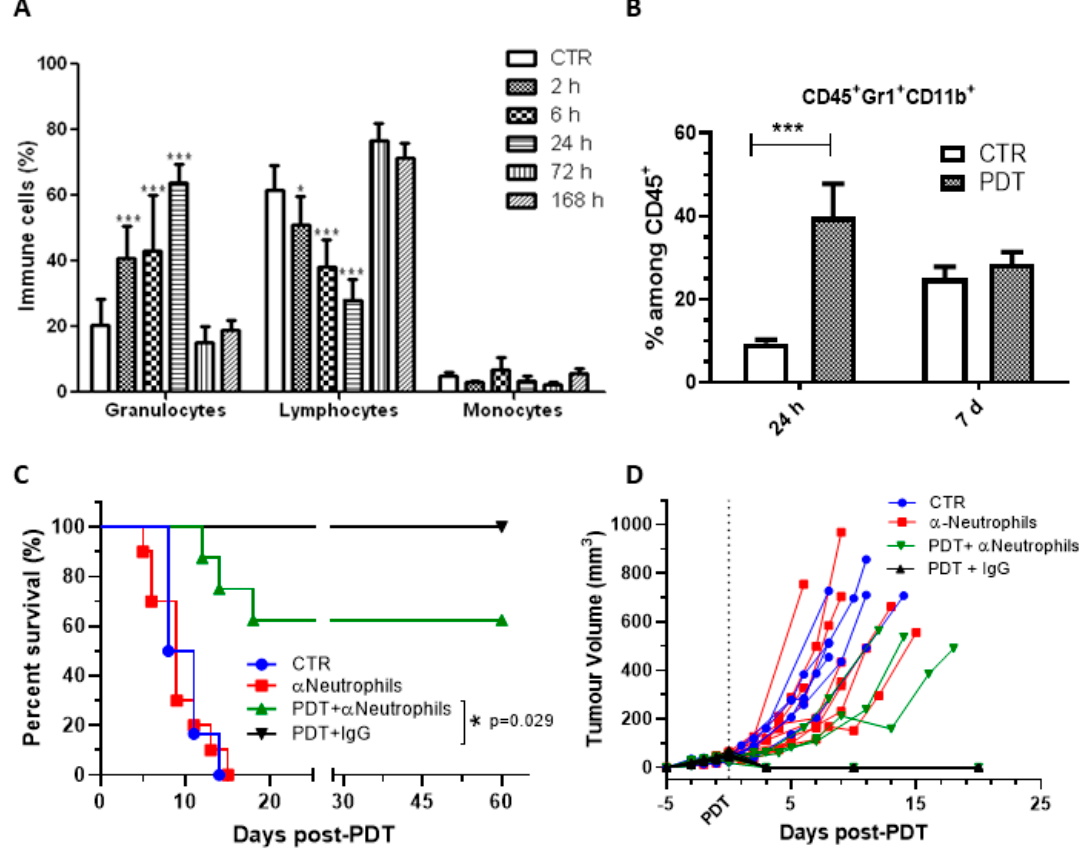
Figure 1. Redaporfin-PDT induces a strong neutrophilia, which contributes significantly for the treatment efficacy. ( A ) Relative percentage of blood leukocyte evaluated by flow cytometry at different time points after redaporfin-PDT. ( B ) Relative percentage of neutrophils (CD45 + , GR1 + and CD11b + ) evaluated by flow cytometry 24 h and seven days after redaporfin-PDT. Bars are the mean ± SD of six mice. No symbol p > 0.05; * p < 0.05; ** p < 0.01; *** p < 0.001. ( C ) Survival curve of mice bearing CT26.WT tumours treated with redaporfin-PDT in normal conditions or upon neutrophils depletion using Ly6G/Ly6C monoclonal antibodies. ( D ) Tumour growth represented individually for each mouse (6–11 mice per group). Survival curve statistics by LogRank (Mantel-Cox) test. No symbol: p > 0.05; * p < 0.05.